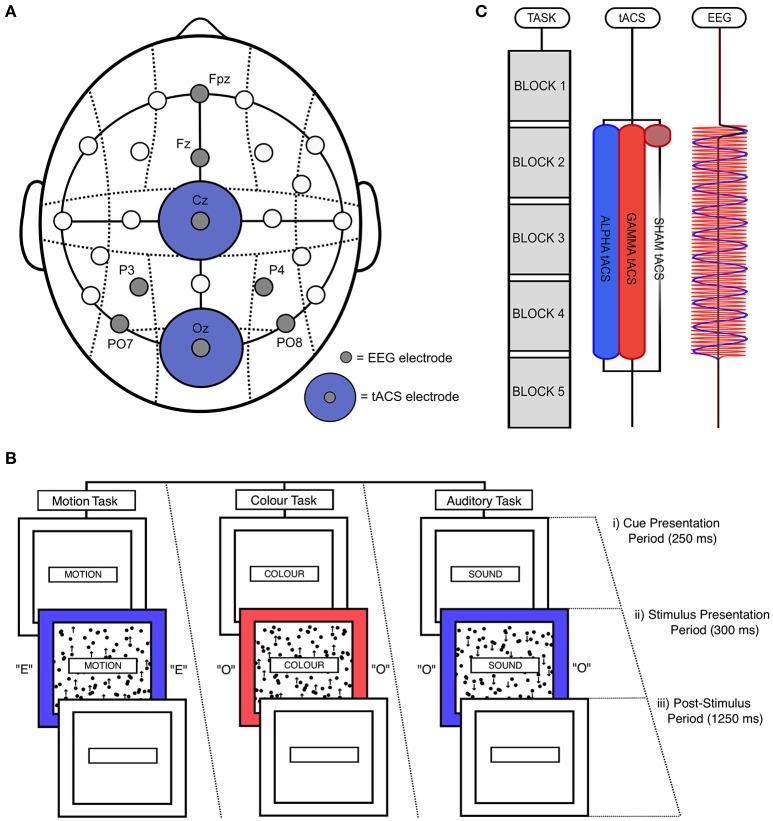
Experimental design. (A) tACS and EEG electrode positioning. EEG electrodes were positioned at PO7, PO8, P3, P4, Fz, and Fpz. tACS electrodes were positioned at Oz and Cz. (B) Illustration of a single, audio-visual switch trial. (i) During the cue presentation period, which lasted for 250 ms, a word was presented in the central box telling participants which task to perform (“MOTION,” “COLOUR,” or “SOUND”). (ii) This was followed by the stimulation presentation period, during which the outer box filled with either red or blue, the inner box filled with black dots that moved in either an upward or downwards direction, and the letter “E” or “O” was played through earphones. This period lasted for 300 ms. (iii) Participants could respond until the end of the post-stimulus period, which lasted for 1,250 ms. (C) Task and stimulation timing. Participants performed five task blocks in a single task session, with each block lasting 4 min and 50 s. A fixed-duration break of 100 s was allowed between blocks. EEG was recorded before and after the delivery of stimulation. During alpha and gamma tACS, stimulation was applied for 19 min and 30 s from the start of the second block to the start of the fifth block. During sham tACS, stimulation was applied at 10 Hz during only the first 50 s of this period (including ramp-up and down times). Participants each performed two task sessions (i.e., 8 blocks in total), separated by a break of 25 min.